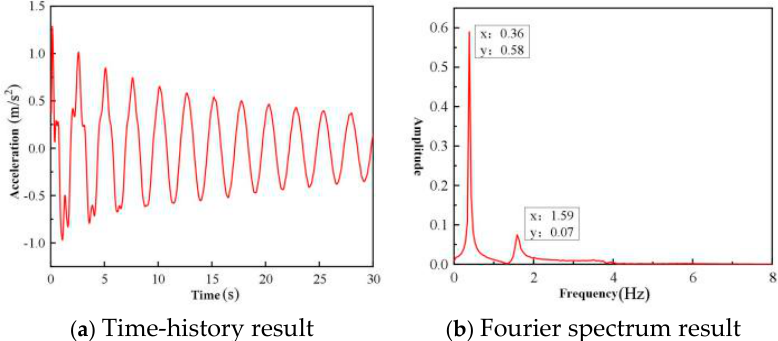
Figure 13. Along-wind acceleration response at monitoring point 1 under a windspeed of 6 m/s.